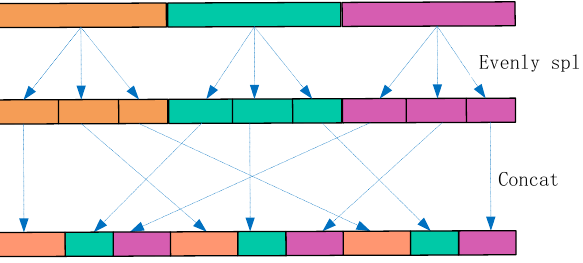
Figure 4. Channel shuffle operation diagram.